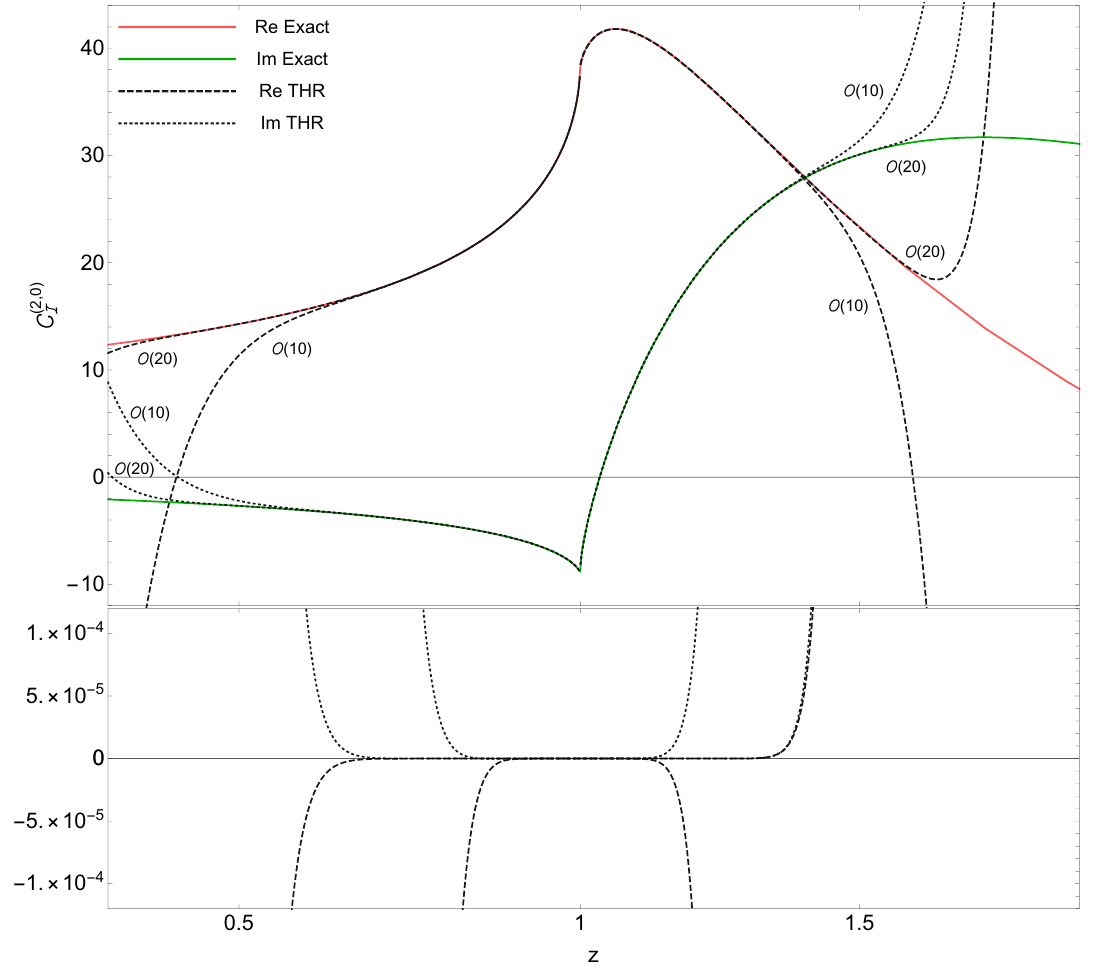
(cid:0) (cid:1) (1 (cid:0) z ) 10 and at I